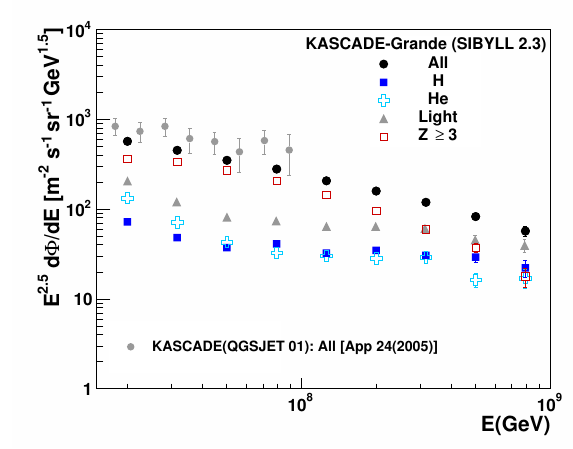
Figure 2. Results of the loglikelihood fit to the measured log ( N µ ) / log ( N ch ) distributions using SIBYLL 2.3 templates 10 10 for five mass groups (H, He, C, Si and Fe) each of them following a double power-law energy spectrum. The fitted all-particle spec- trum (black dots) and mass group spectra (H: solid blue squares, He: open sky blue circles and C + Si + Fe: open red squares) are shown for E = 10 PeV - 1 EeV. The light component (H + He: gray triangles) is also displayed.